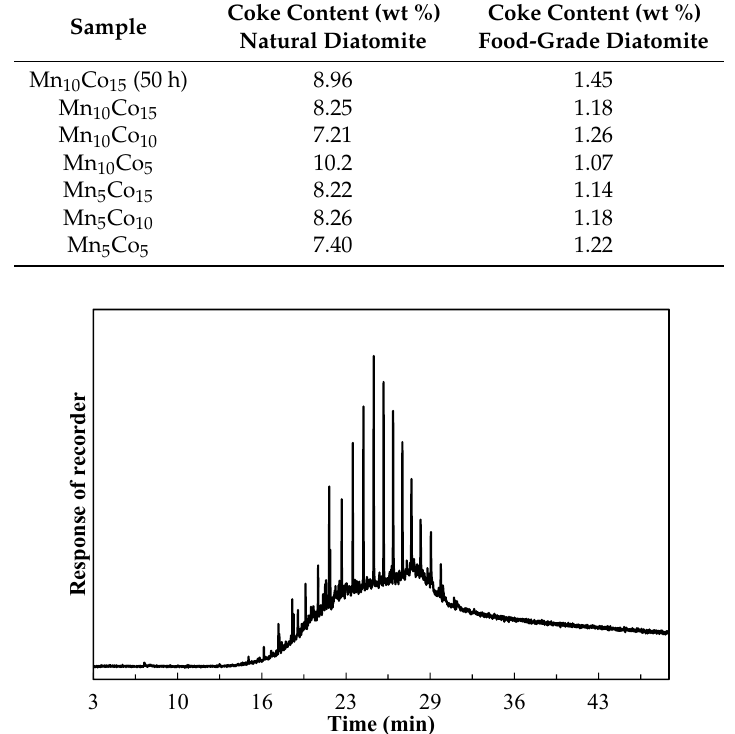
Table 5. TGA analysis result for the used samples.